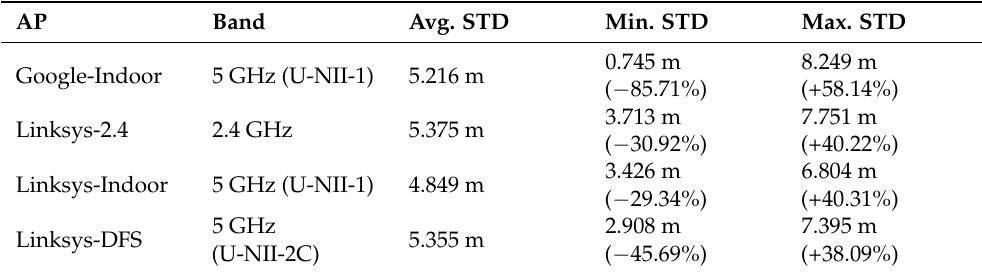
Table 6. Stability of the RTT observations (minimum, maximum, and average standard deviation) for each AP vendor and frequency channel.